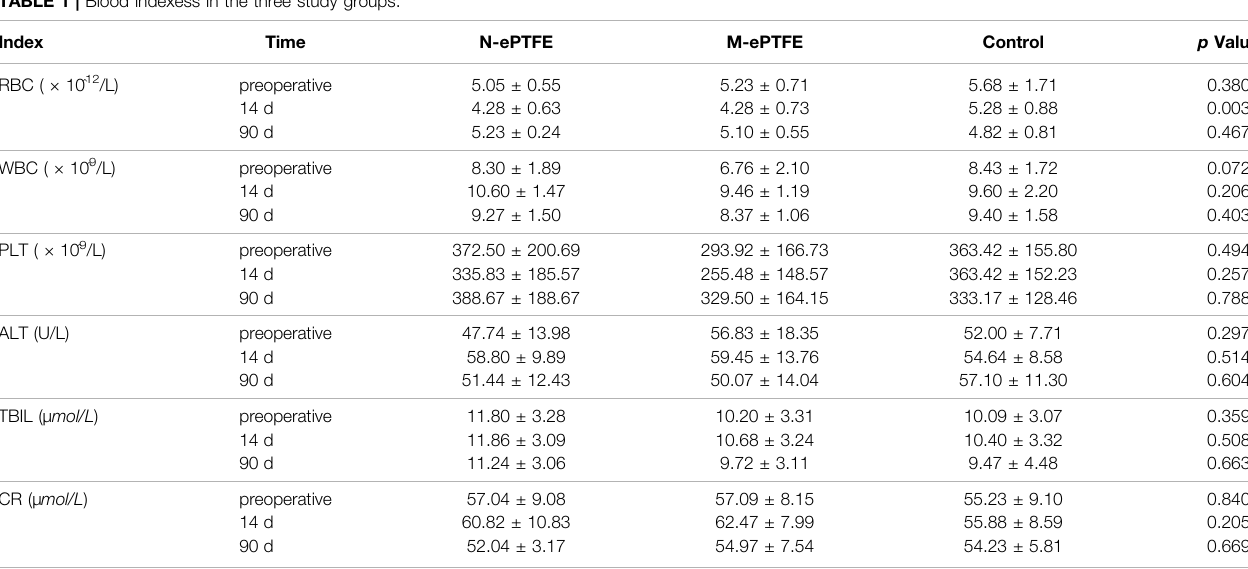
TABLE 1 | Blood indexess in the three study